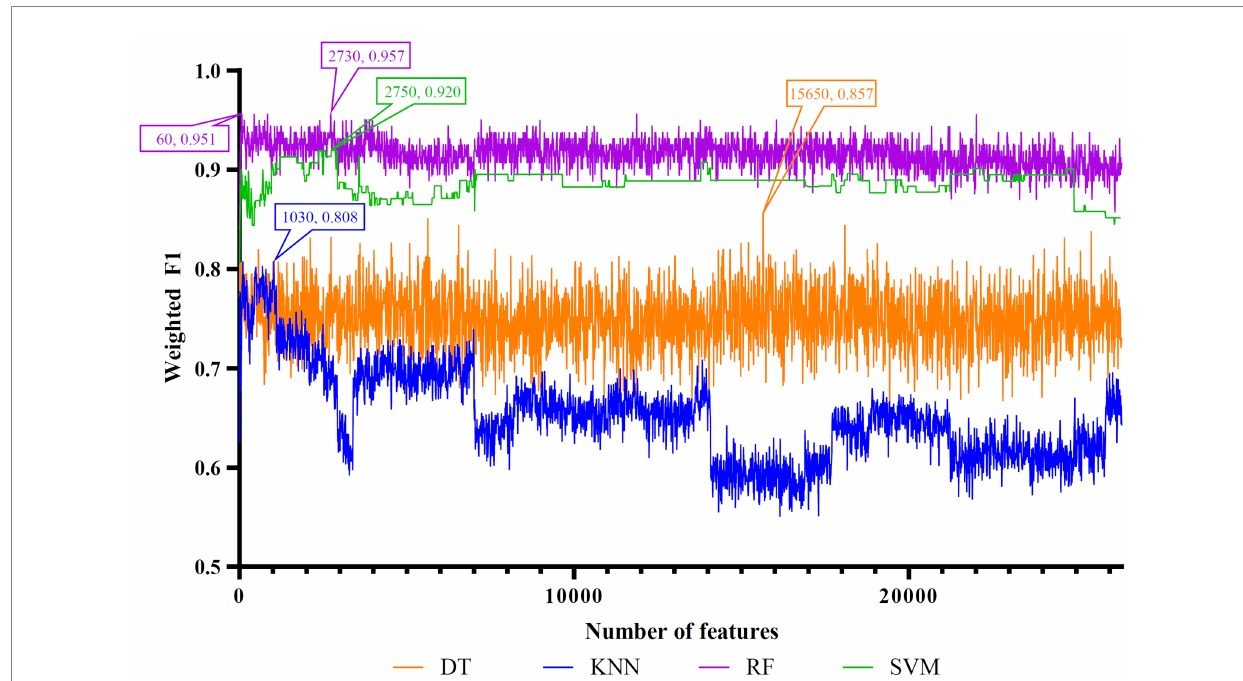
FIGURE 3 IFS curves of four classification algorithms on LightGBM feature list. DT, KNN, RF, and SVM yielded the highest weighted F1 values of 0.857, 0.808, 0.957, and 0.920 when top 15,650, 1,030, 2,730, and 2,750 features were adopted, respectively. RF can yield quite high performance (weighted F1 = 0.951) when top 60 features were